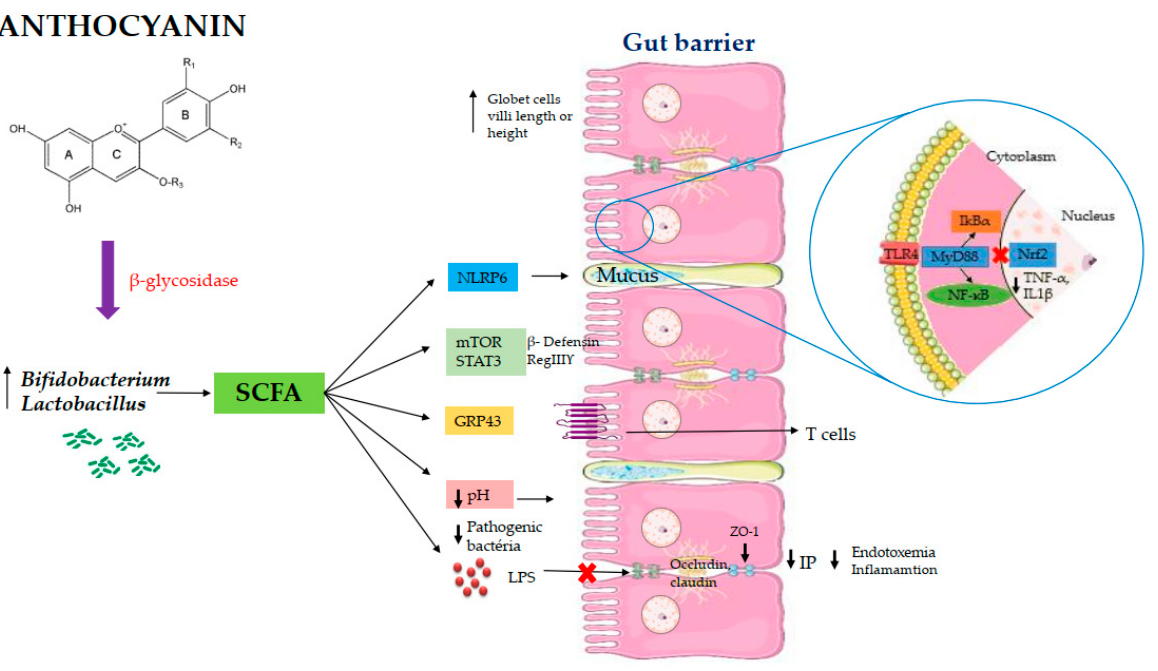
Figure 3. Proposed mechanisms of action of anthocianins on intestinal health. Abbreviations: ZO-1: zonula occludentes– 1; SCFA: short chain fatty acids; LPS: lipopolysaccharides; TLR-4: Toll like receptor 4; IP: intestinal permeability; mTOR: mammaliam target of rapamycin; STAT3: signal transducers and activator of transcription 3; NF-kB: factor nuclear kappa B; MyD88: Myeloid differentiation primary response 88; IkB α : I-Kappa-B-alpha; NLRP6: inflammasome nucleotide-oligomerization domain-like receptor 6; GRP43: G protein-coupled receptor; TNF- α : tumor necrosis factor alpha IL1 β :interleukin 1 beta; Nrf2: erythroid-2-related